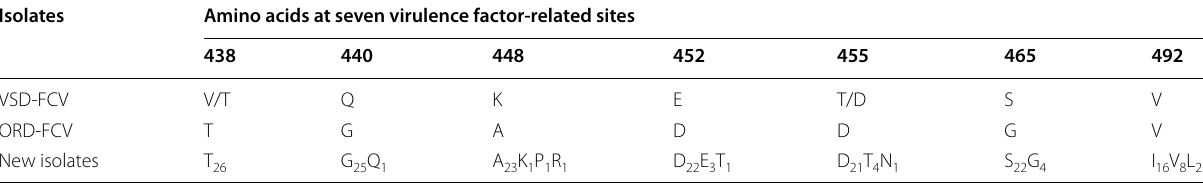
Table 5 Comparison of amino acids at seven virulence factor-related sites between 26 isolates and reference strains Isolates Amino acids at seven virulence factor-related